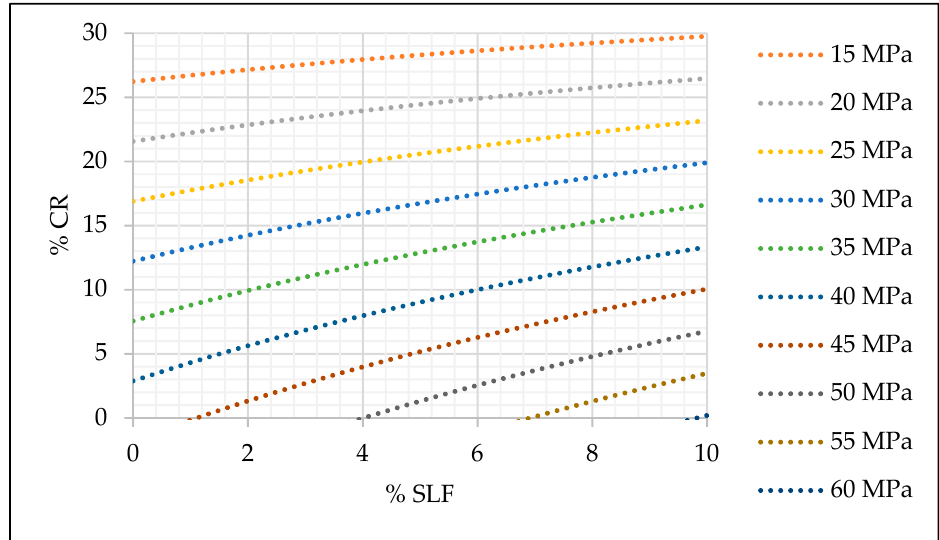
Figure 15. Prediction model for SCC compressive strength (fck = 43.09240 − 1,07104 × cr + 1.72105 × slf − 0.04515 × cr × slf).